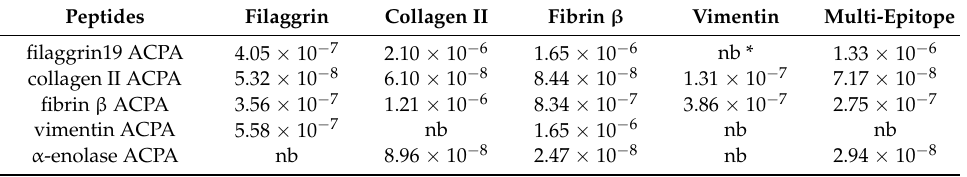
Table 2. K D of affinity purified IgG of anti-peptide antibodies as measured by SPR (surface plasmon resonance). Table 2. K D ofaffinitypurifiedIgGofanti-peptideantibodiesasmeasuredbySPR(surfaceplasmonresonance).